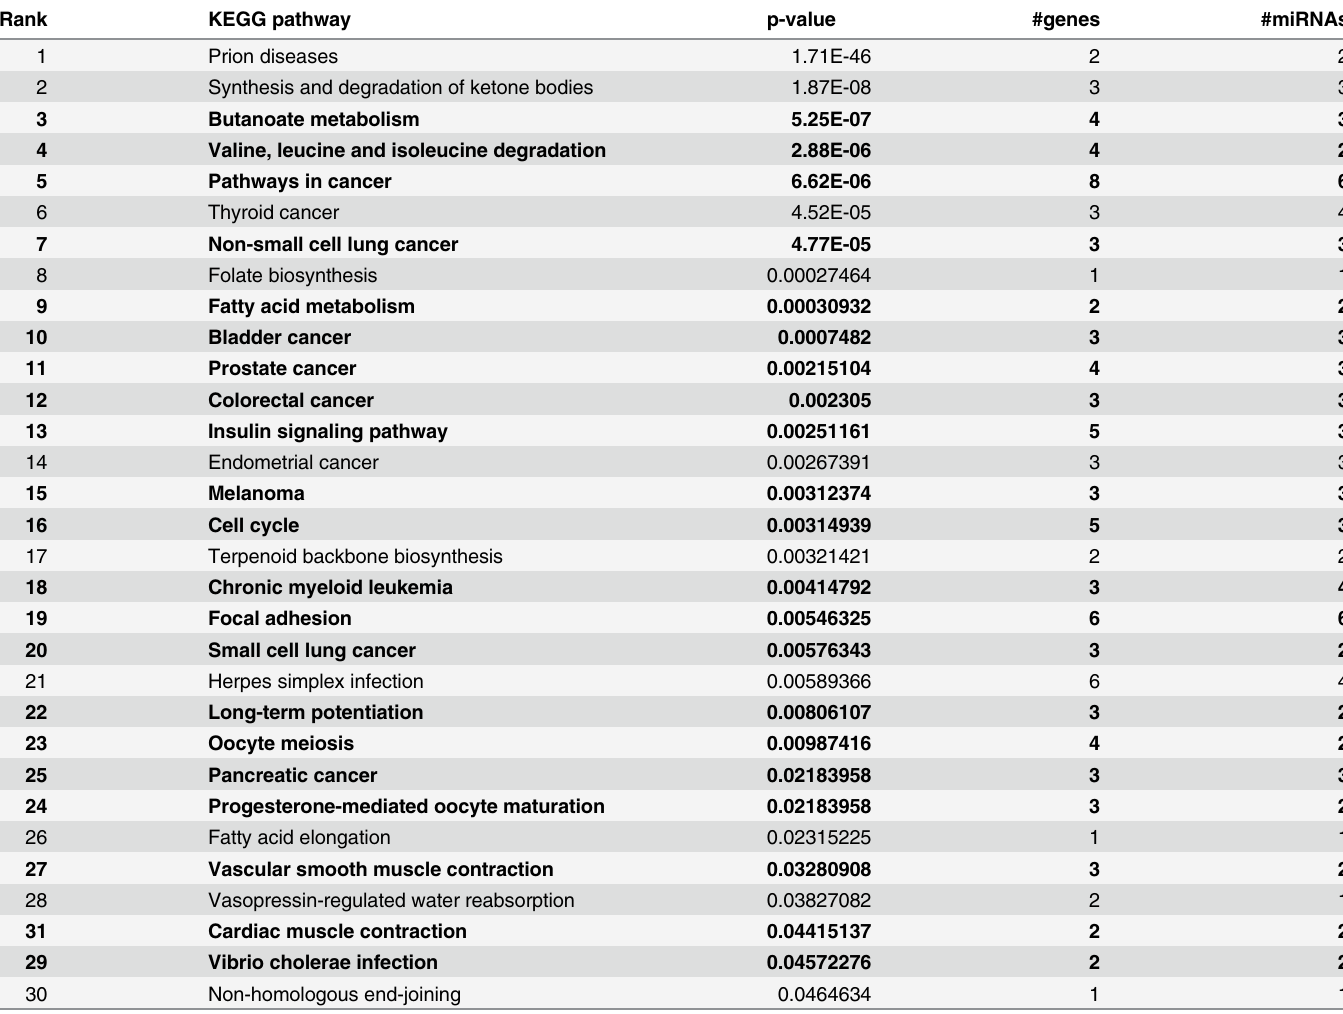
Table 6. KEGG signaling pathway enrichment of miRNA-mRNA targets in the whole blood of workers exposed to MWCNTs.